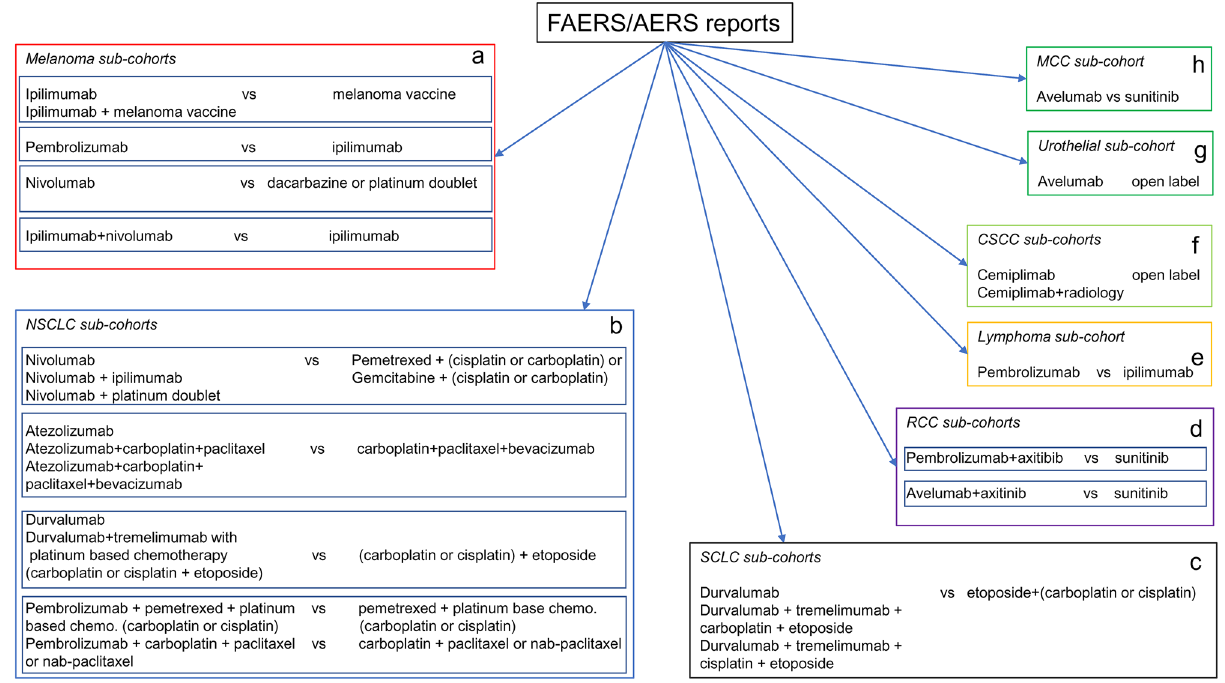
Figure 2. FAERS/AERS cohorts based on indications and treatments in efficacy trials for all ICIs. The two groups on each sub-cohort indicate the treatment vs control used in the efficacy trials. NSCLC